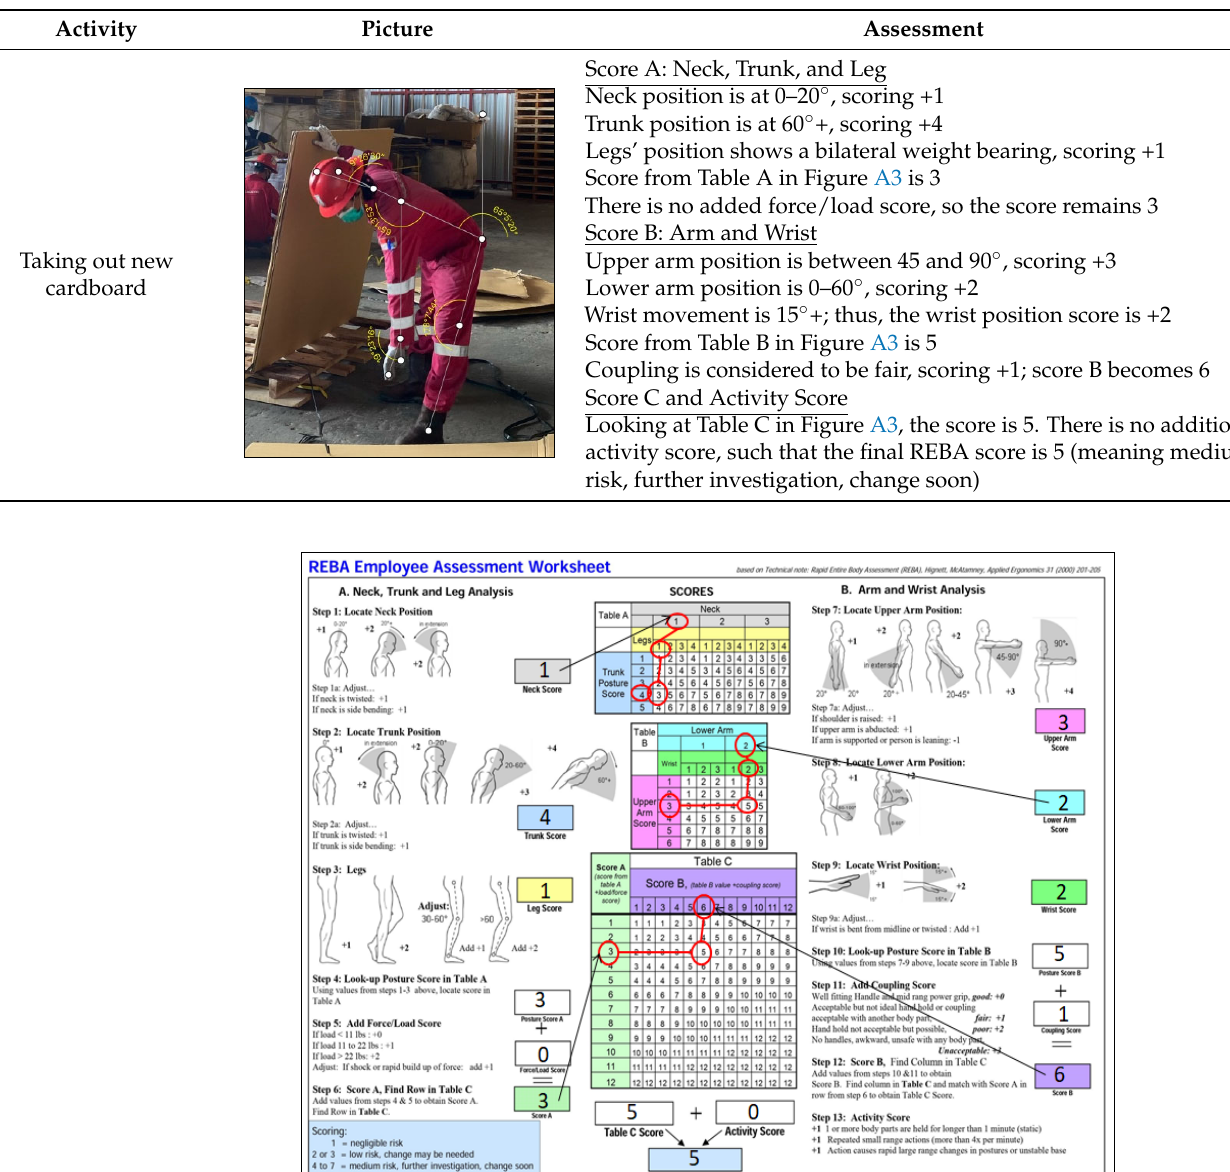
Table A2. Example of the REBA assessment.